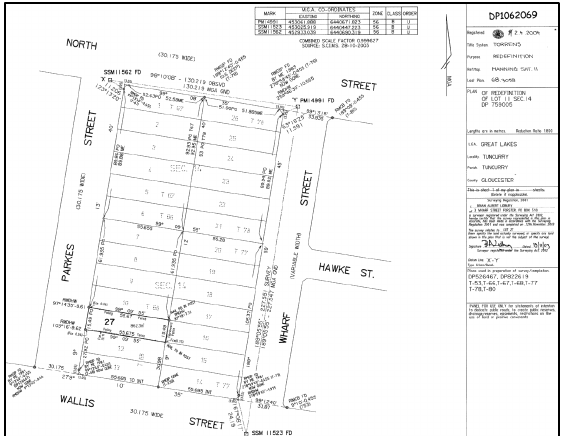
Figure 1: A deposited plan to be